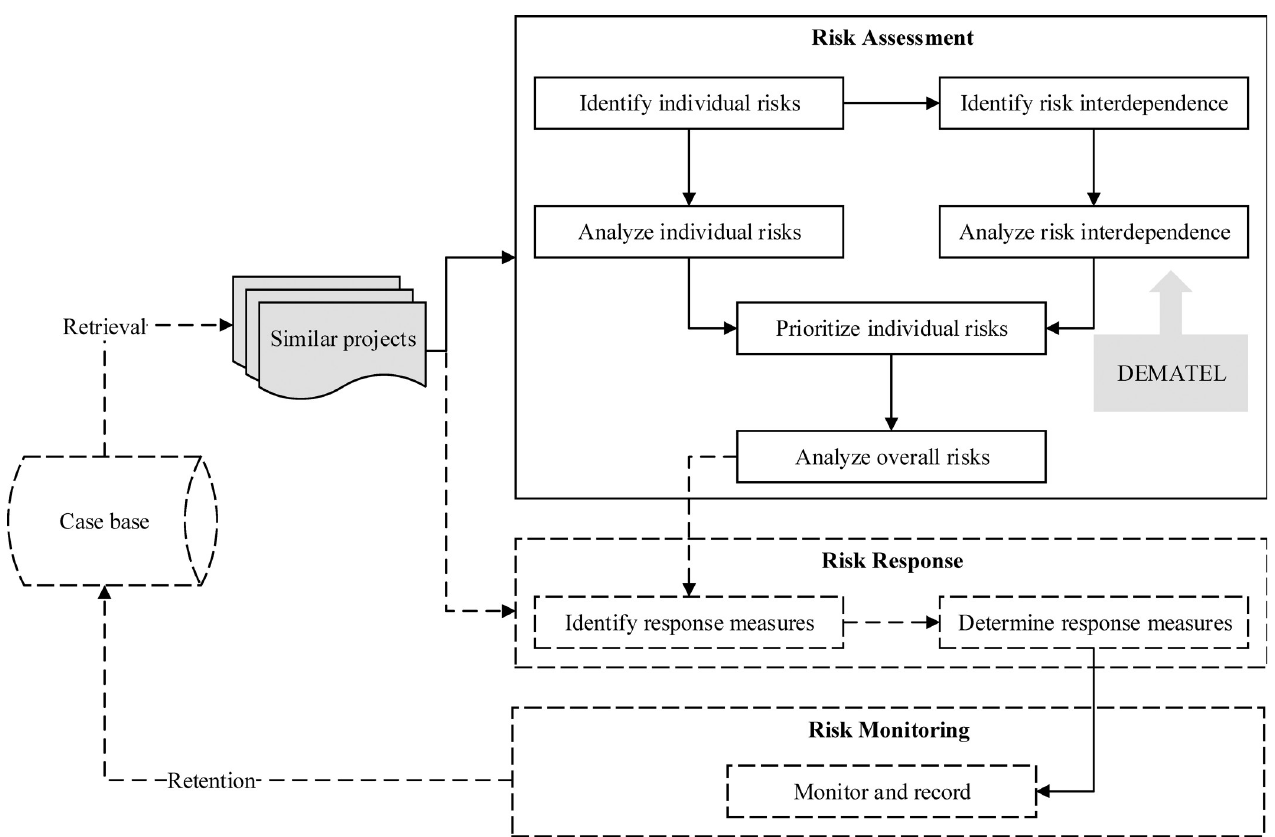
Fig 1. Risk assessment model for international construction projects that considers risk